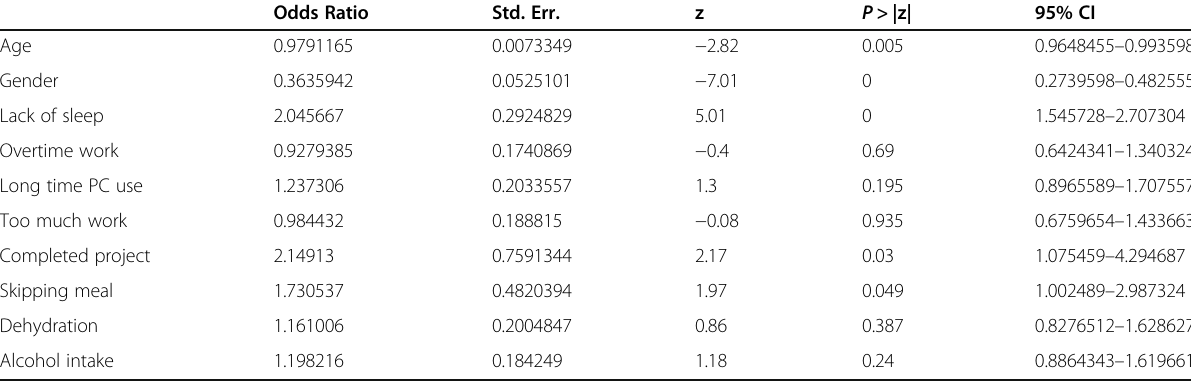
Not able to concentrate, mean